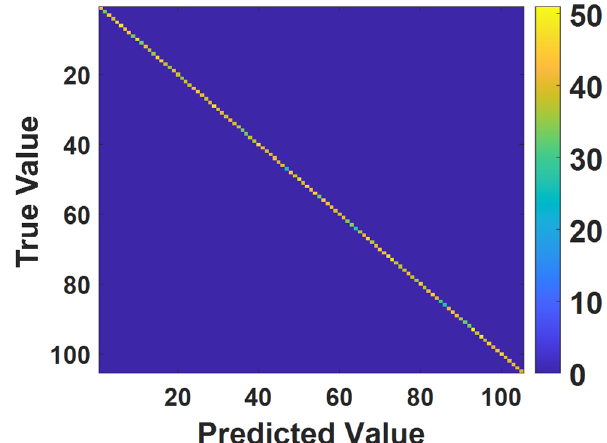
Figure 7. The confusion matrix of the testing set.